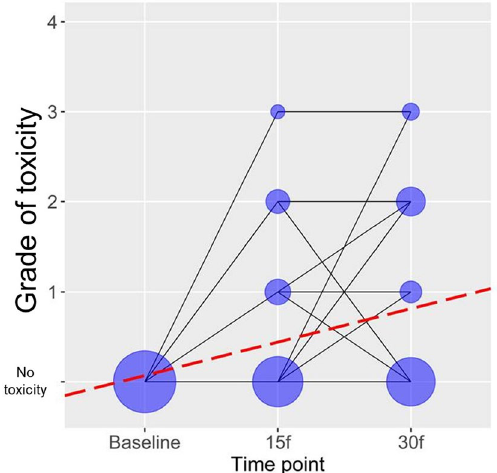
Figure 1. Grade of toxicity over time during treatment with RT and TMZ. “No toxicity” represents patients at baseline, before treatment. It does not represent grade. The grade of toxicity was defined as 1, 2, 3, and 4 (in our cohort there were no patients with grade 4 toxicity, although the maximal grade according to CTCAE ver.5.0 scoring is 4). *According to CTCAE ver. 5.0 grade 5 (death) is not adequate for some adverse events and therefore was not an option.